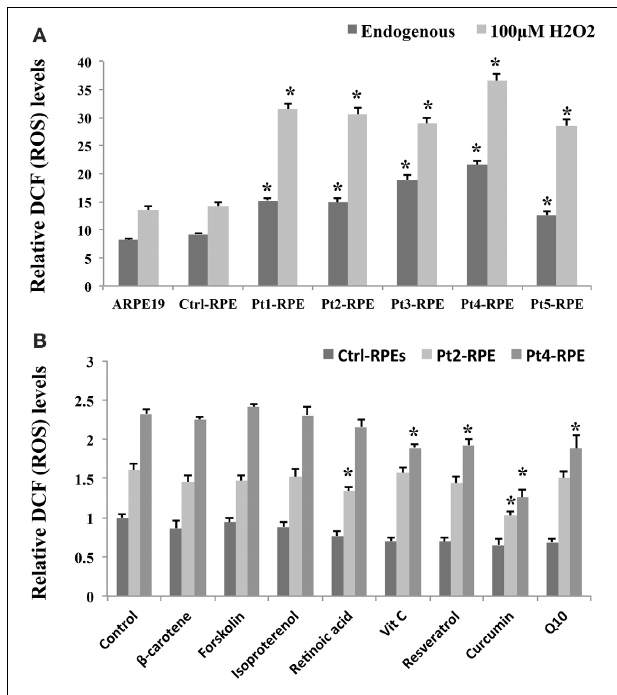
FIGURE 4 | Accumulation of endogenous ROS in AMD-RPEs as a drug screening platform. (A) Endogenous and H 2 O 2 -induced ROS were measured with flow cytometry. In H 2 O 2 -induced ROS group, RPE cells were separately pretreated with 200 μ M H 2 O 2 for 6h. Each bar represents the mean ± SD of three independent experiments ( ∗ p < 0 . 05, compared with ctrl-RPE). (B) Endogenous ROS were measured by flow cytometry after treatment with dietary supplements for retinal protection and natural compounds for anti-oxidative stress for 24h (10 μ M β -carotene, 10 μ M retinoic acid, 5 μ M forskolin, 200 μ M isoproterenol, 10 μ M resveratrol, 10 μ M vitamin C, 10 μ M curcumin, and 20 μ M Q10). Each bar represents the mean ± SD of three independent experiments ( ∗ p < 0 . 05, compared with non-treated